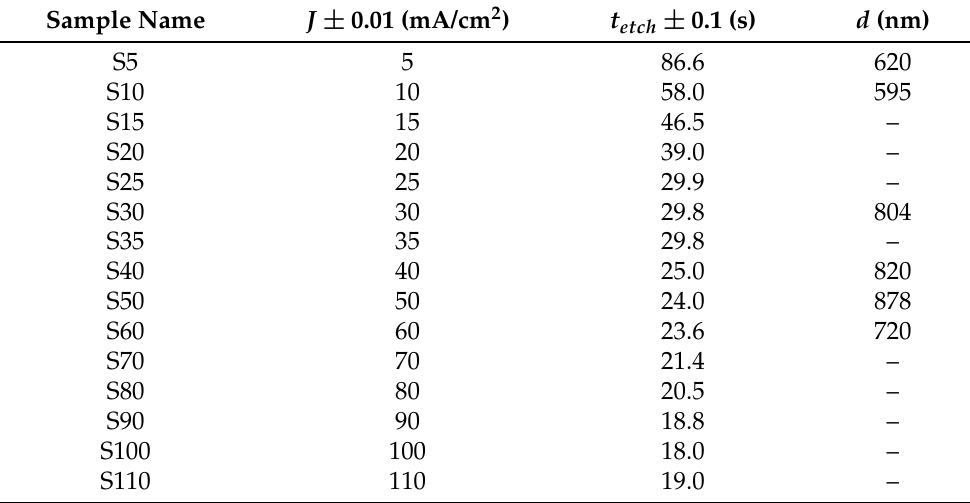
Table 1. Anodizing conditions of PSi samples. The anodizing time reduces monotonously as a function of current density. All samples were etched during four photoacoustic